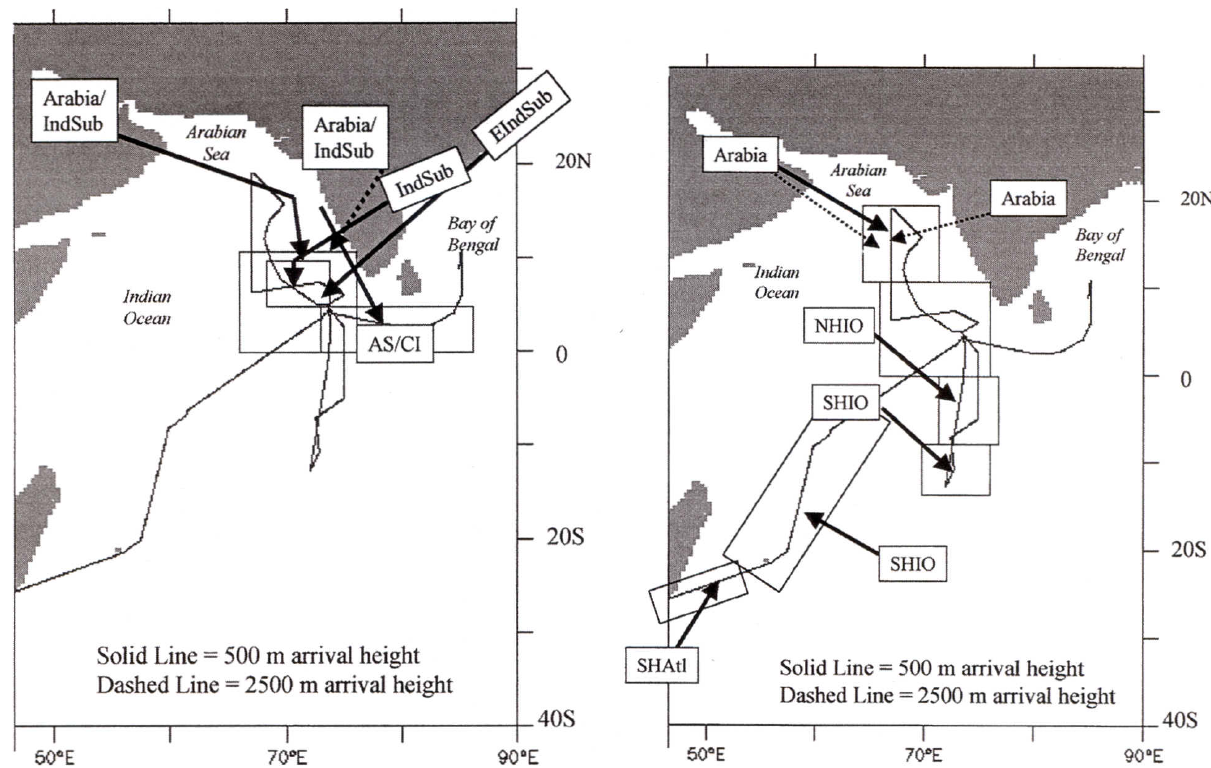
Fig. 28. Airmass origins along the RV Ronald H. Brown cruise track, with boxes indicating where air masses from the different source regions were encountered along the cruise track (see Table 7 for explanation of the source region abbreviations). Airflow is shown for 500m arrival height trajectories (solid line), and also for 2500m arrival height trajectories (dashed line) when they differed significantly (from Quinn et al., 2002, copyright 2002 by the American Geophysical Union, reproduced with permission).